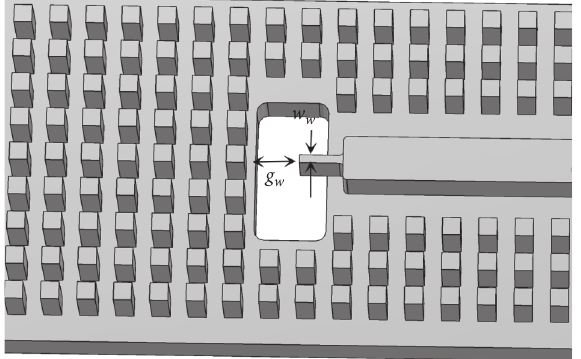
Figure 13: Geometry of the rectangular waveguide to ridge gap waveguide transition ( w p � 0.4mm and g p � 2.23mm).